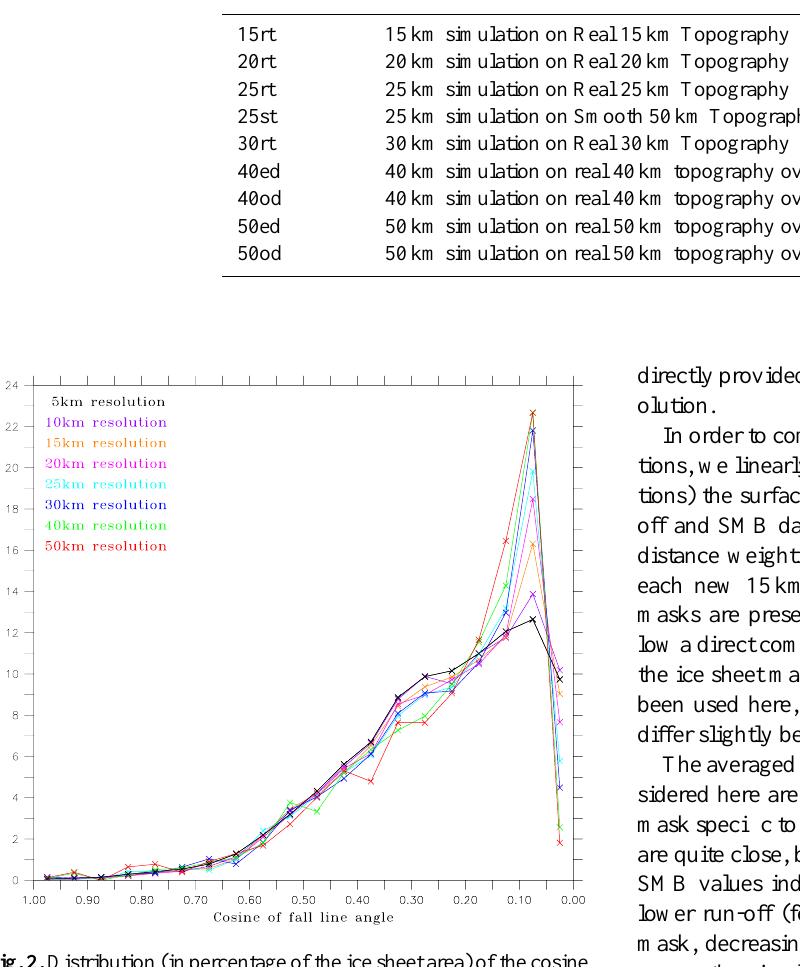
Table 1. Definition of the different MAR simulations performed in the framework of this study, and their related abbrevations. Abbreviation